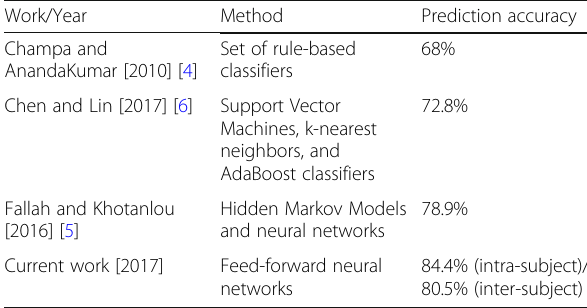
Table 5 Comparison with state-of-the-art Work/Year Method Prediction